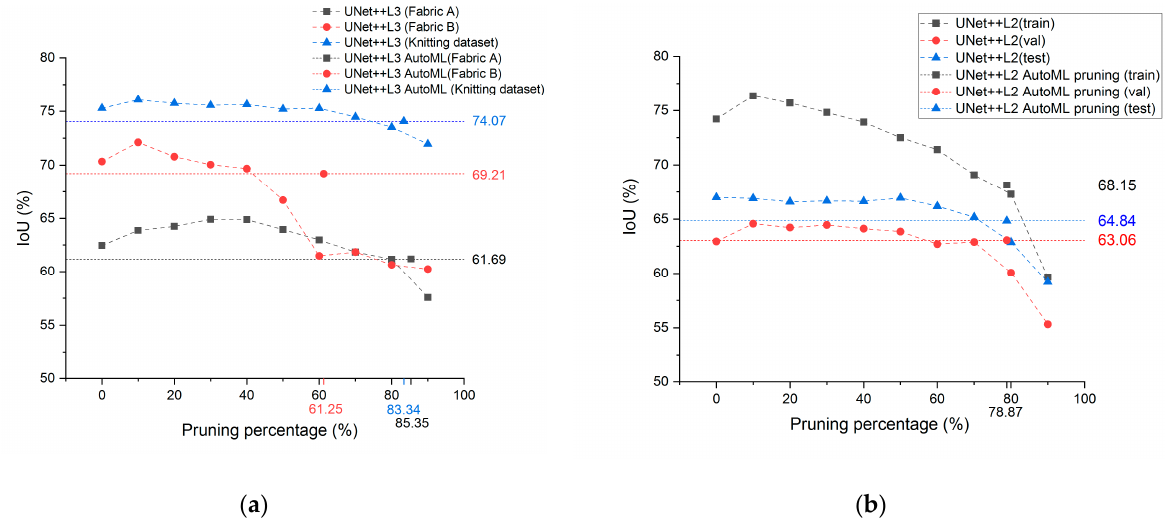
Figure 11. This UNet++ result can be achieved after completing the stage 2 training, and the pruning percentage of each layer of the network is the same. After completing the stage 3 training, the UNet++ AutoML pruning result indicated in the figure can be obtained. As the pruning percentages differ for each respective network layer, the percentage represents the mean value of each layer for the following: ( a ) the IoU of Fabric A, Fabric B, and the knitting dataset after the network pruning; ( b ) the IoU after the pruning of the nano fiber dataset. Table 5. UNet++ prediction speed comparison table.